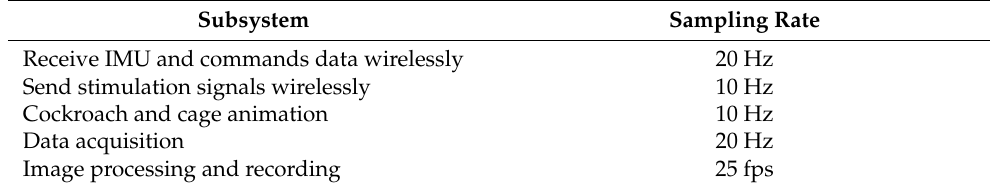
Table 2. The sampling rate of the proposed teleoperated biobot using a multithreading algorithm.